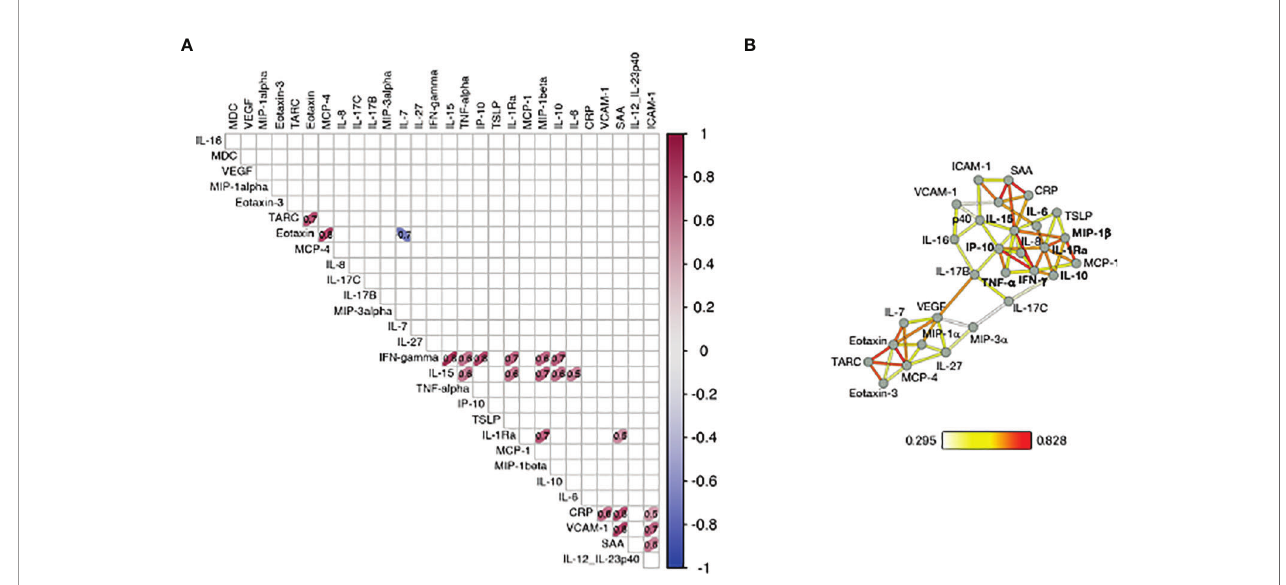
FIGURE 3 | Correlation of cytokine changes upon 2 nd vaccination in patients. Pairwise correlations were calculated among the cytokines log2FC at d23 in comparison to d22, using the Spearman correlation coef fi cient (adjusted p value < 0.05). The analysis was performed for patients with moderate-to-high Ab responses to the vaccine (n = 25). (A) Correlation matrix for the 2 nd vaccination is plotted as heatmap. Spearman r values of correlations are indicated in the grid cells and ellipses identi fi ed signi fi cant correlations. The color and shape of ellipses correspond to the value of the Spearman correlation coef fi cient with red color indicating a positive correlation. (B) The network analysis represents the correlation pro fi le among cytokine changes after 2 nd vaccination in patients. The color-coded edges represent the Spearman correlation coef fi cient (r) between two speci fi c analytes, depicted as